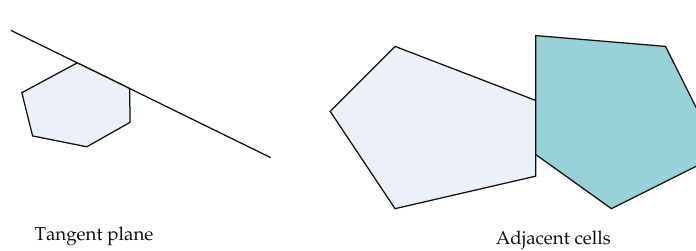
Figure 3: Illustration of tangent plane and adjacent cells.